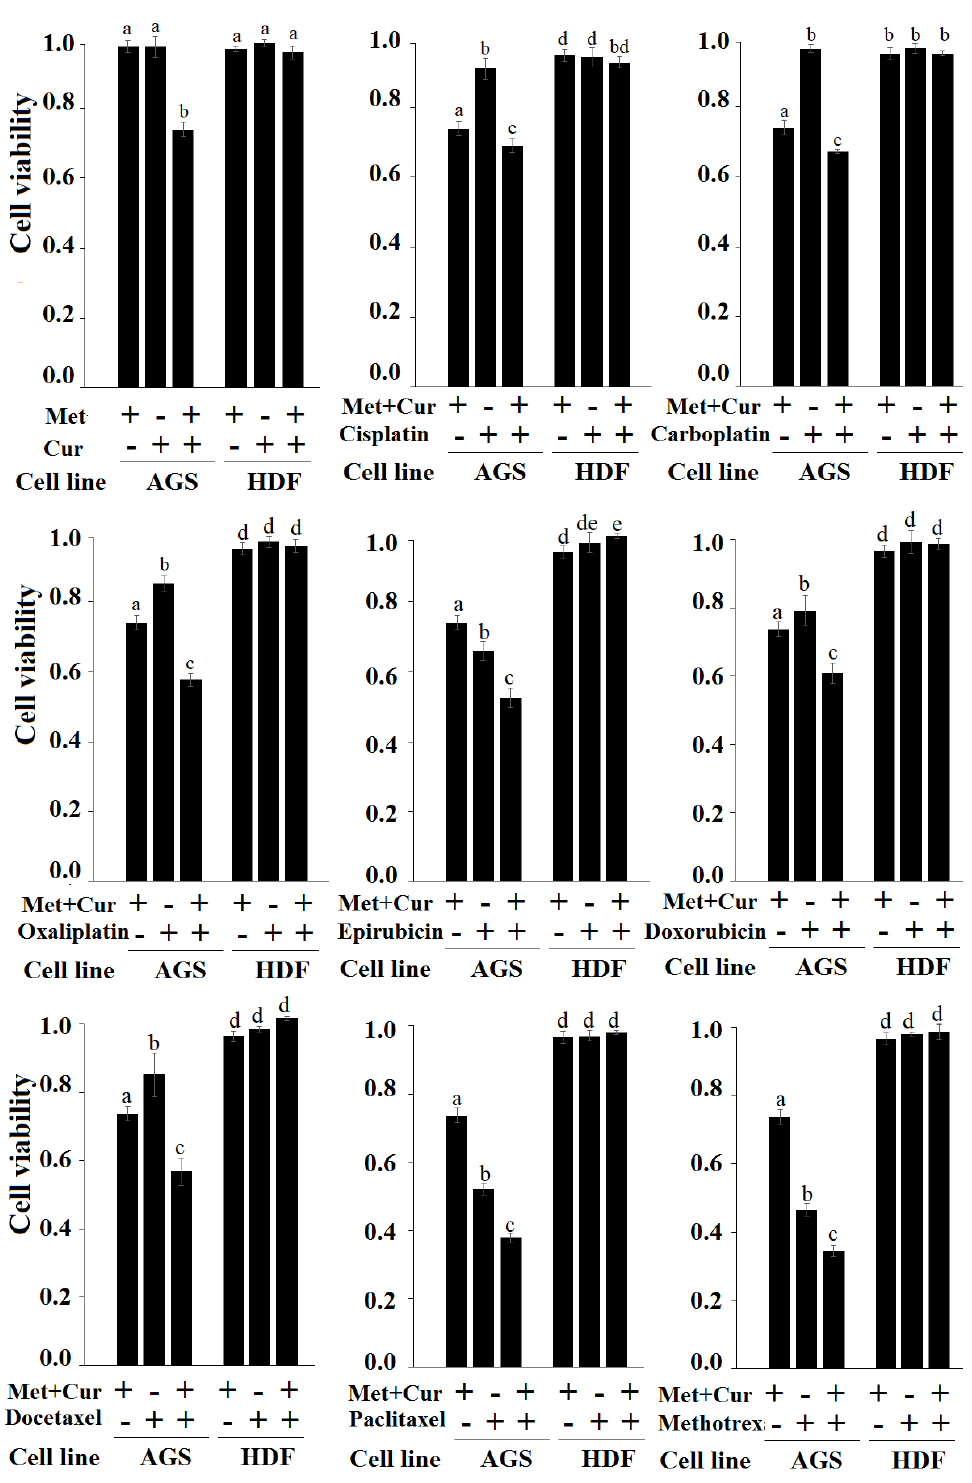
Figure 4: Treatment of cancerous AGS and normal HDF cells with metformin (Met), curcumin (Cur), “Met + Cur”, and anticancer drugs (with and without combination of “Met + Cur”) for 48 hours. Met, Cur, cisplatin, carboplatin, oxaliplatin, epirubicin, doxorubicin, docetaxel, paclitaxel, and methotrexate were used at final concentrations of 0.625 mM, 0.5µM, 1.2 µM, 0.4 µM, 0.4 µM, 37 nM, 37 nM, 1.2 µM, 0.4 mM, and 37 nM, respectively. The results are the means of three independent experiments. Statistical analysis was performed using one-way ANOVA with Duncan’s post-hoc test. Analysis indicates an in- crease in the specific cytotoxicity of anticancer drugs in the presence of “Met + Cur”. In each panel, a similar alphabet does not imply statistical